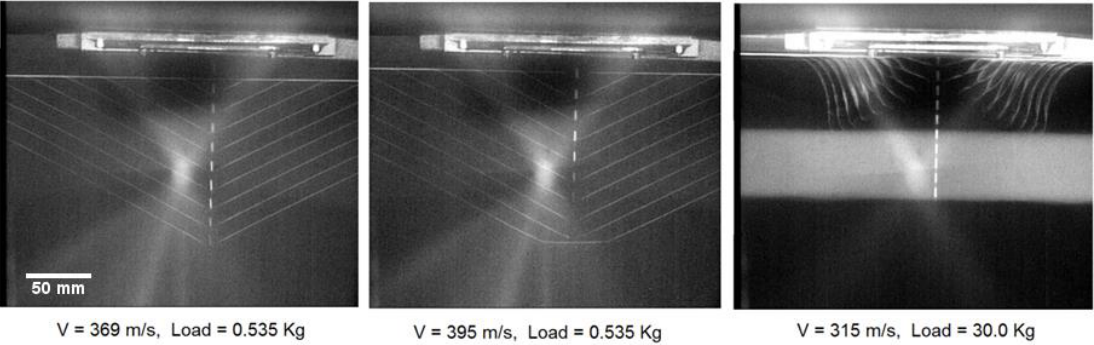
Figure 5. Three photographs showing a sequence of exposures of transverse wave progression in three yarn shooting tests (The white bar in the right image is a photographic artifact).